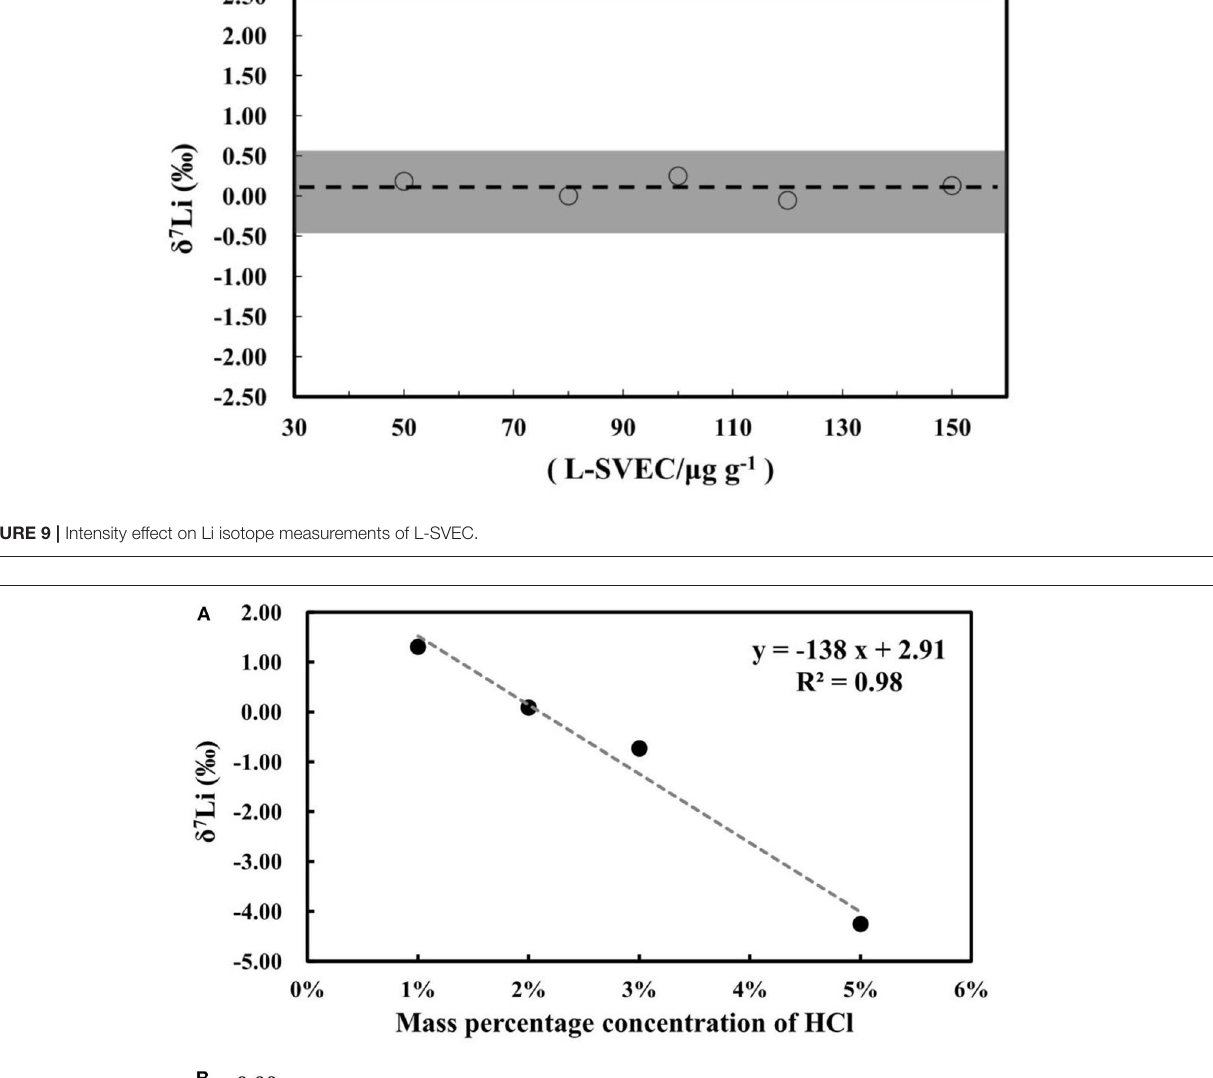
Frontiers in Chemistry |